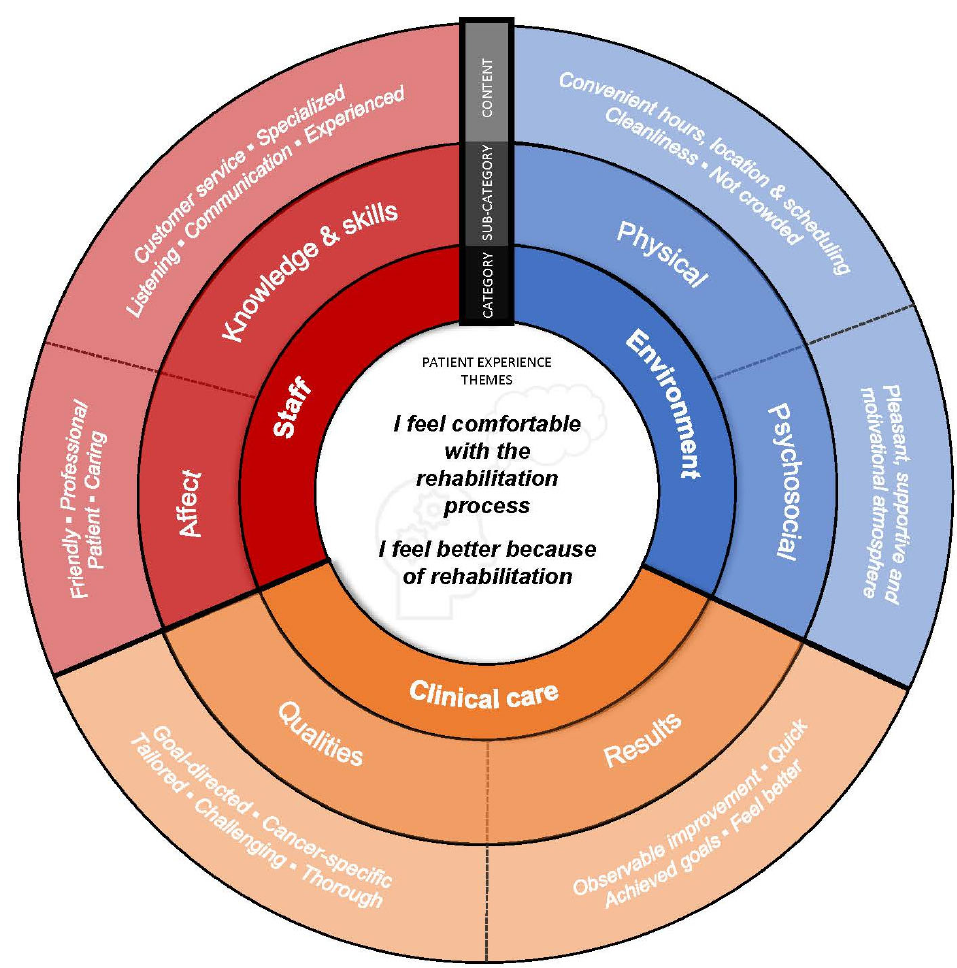
Figure 1. Aspects of patient experience associated with recommending cancer rehabilitation ser ‐ vices.